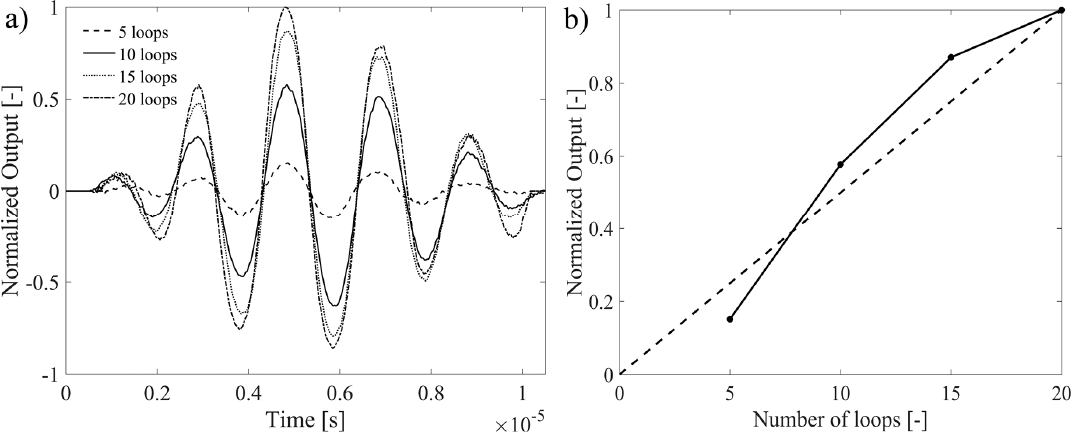
Figure 8. Toneburst signals acquired by the FOC sensor as a function of different number of fiber loops.